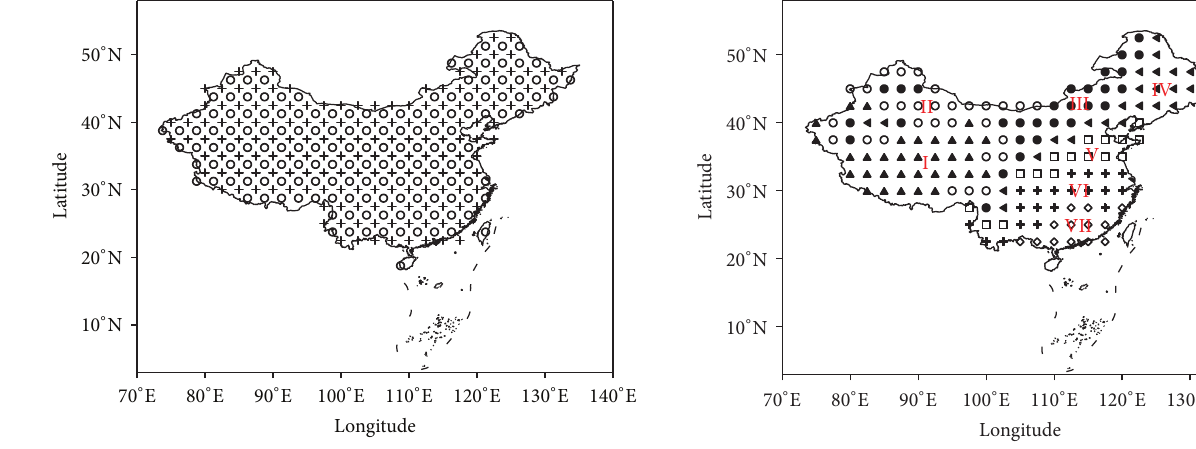
Figure 1: Distribution of grid-point locations for NCEP/NCAR PW (crosses) and CMAP precipitation (circles).